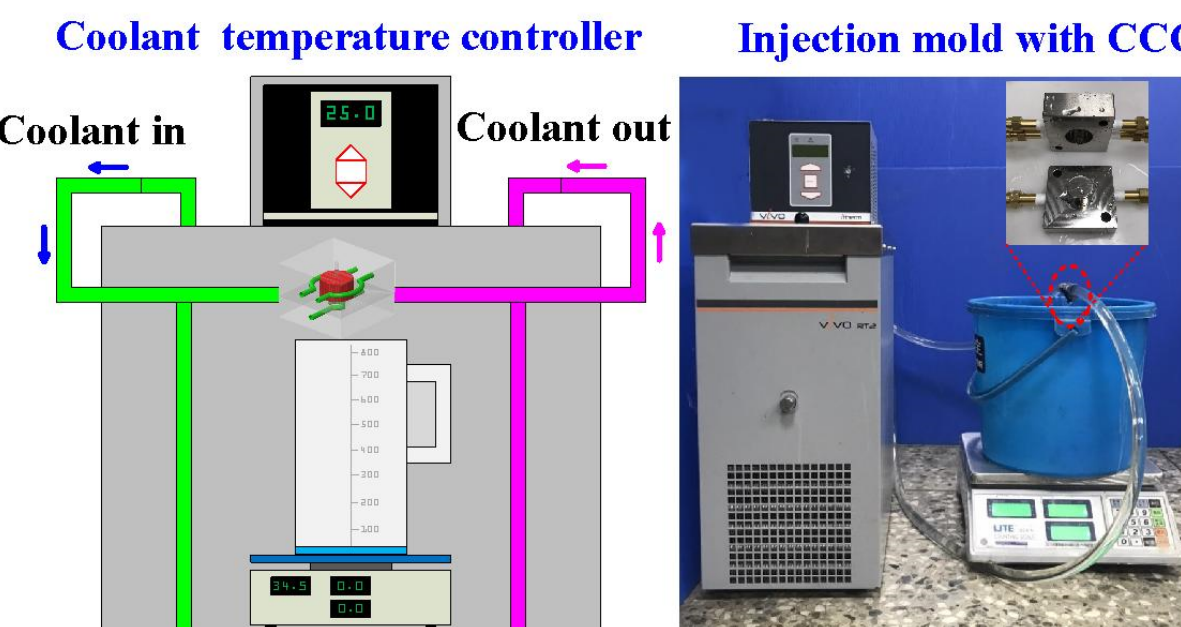
Figure 3. Experimental setup for investigating the amount of coolant leakage using a precision electronic scale.